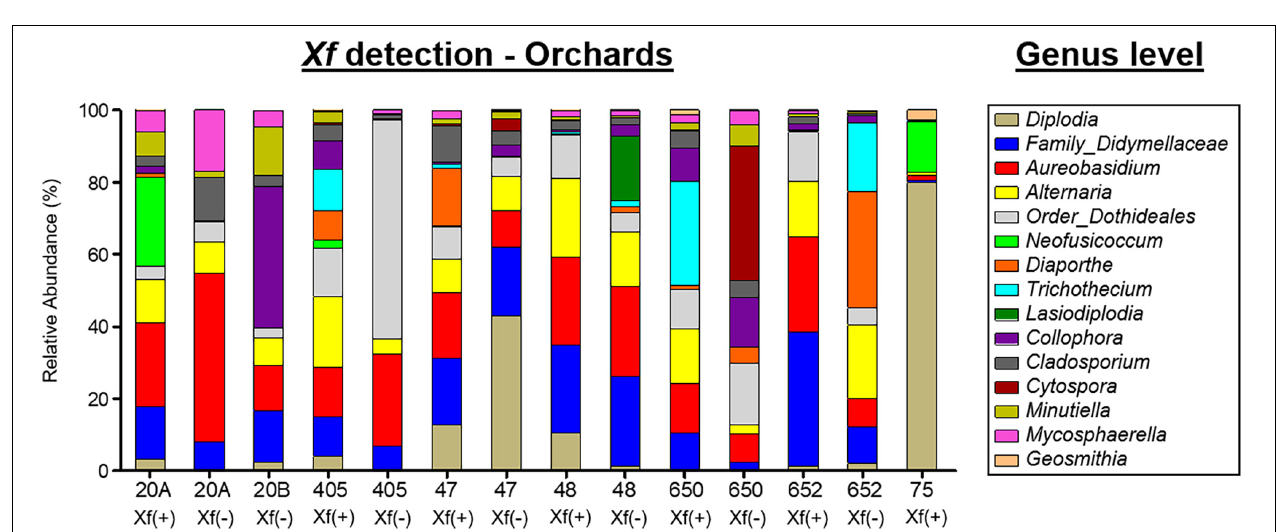
FIGURE 6 | Bar plots showing the relative abundance of fungal taxa at the genus level present in the xylem of almond trees sampled in different orchards in Alicante province. X. fastidiosa (+) and X. fastidiosa (–) refer to Xylella fastidiosa -infected or non-infected almond trees, respectively.